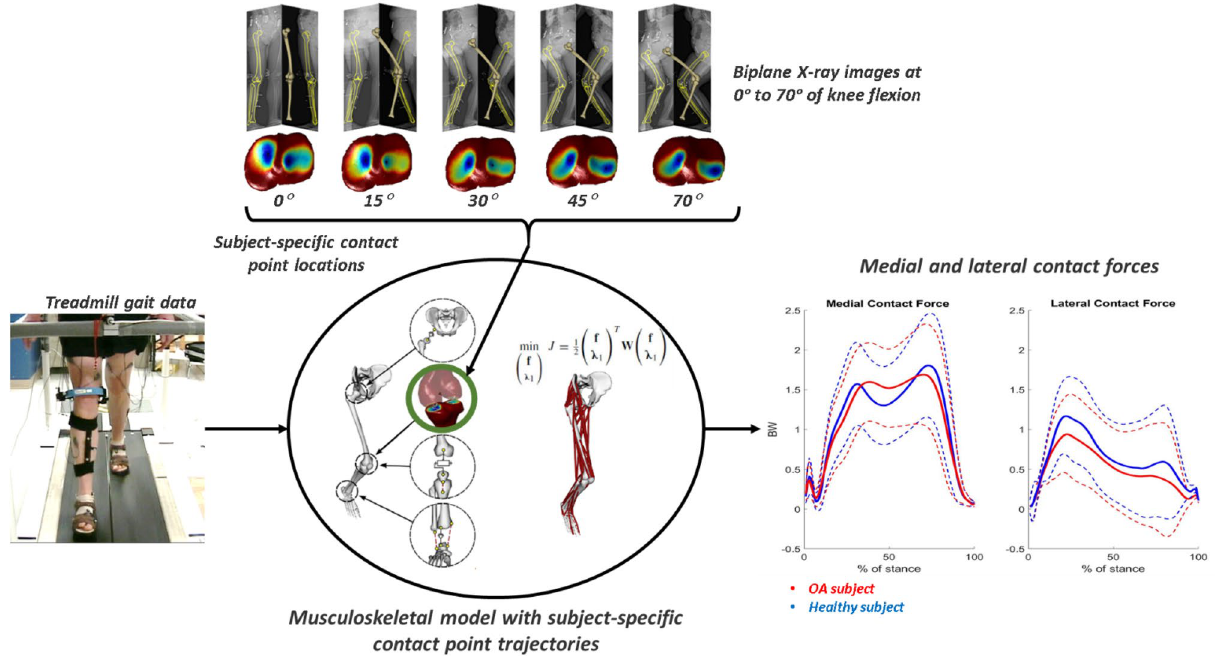
Figure 1. The process of estimating the medial and lateral contact forces using the subject-specific contact point